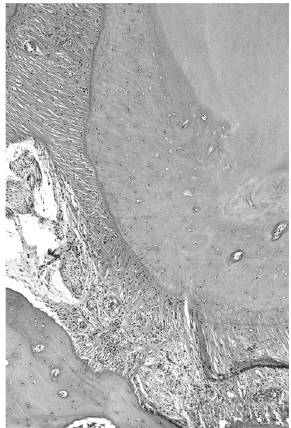
Figure 8. Group III (calcium hydroxide). Apical and periapical regions showing the periodontal ligament with normal thickness and absence of inflammatory cells infiltrate. HE; magnification X24. Table 1. Results of the histopathologic analysis.